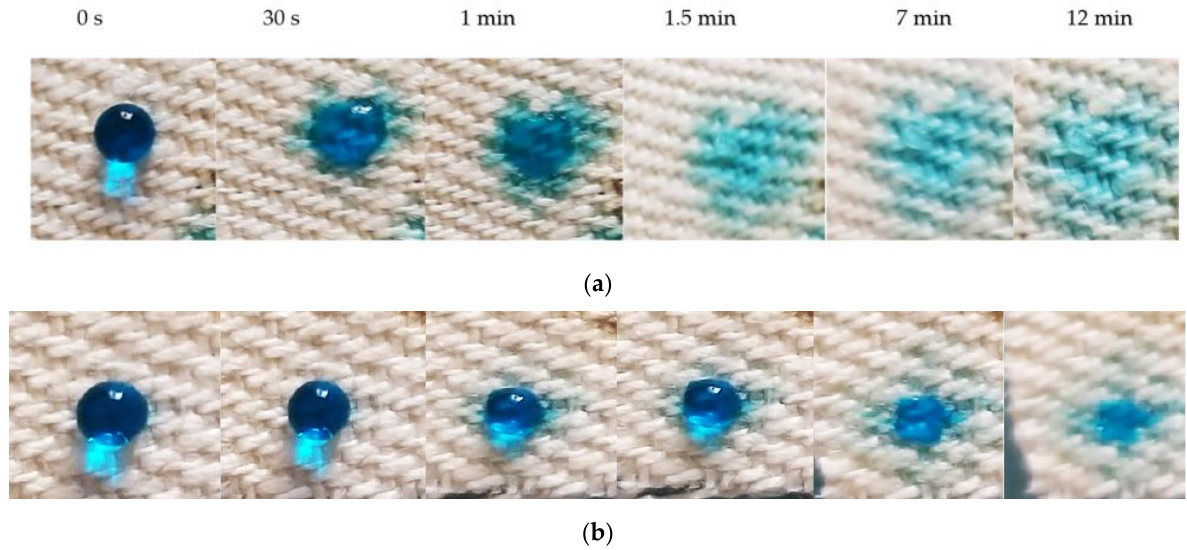
Figure 9. Sorption process of Reactive Blue 21 aqueous solution on Thin Film of Chitosan deposited by LICD from Oyster Shell on hemp twill fabric ( a ) and on hemp twill fabric itself ( b ).